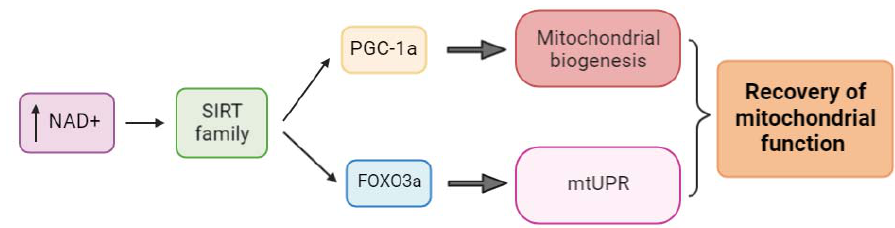
Figure 4. Sirtuins link between mitochondrial biogenesis and the mtUPR. The SIRT deacetylase family is activated by increased NAD+ levels and induces, on the one hand, mitochondrial biogenesis via the deacetylation of PGC-1 α caused by SIRT1/SIRT3, and, on the other hand, the mtUPR through FOXO3a deacetylation by SIRT3, improving mitochondrial dysfunction and recovering mitochondrial